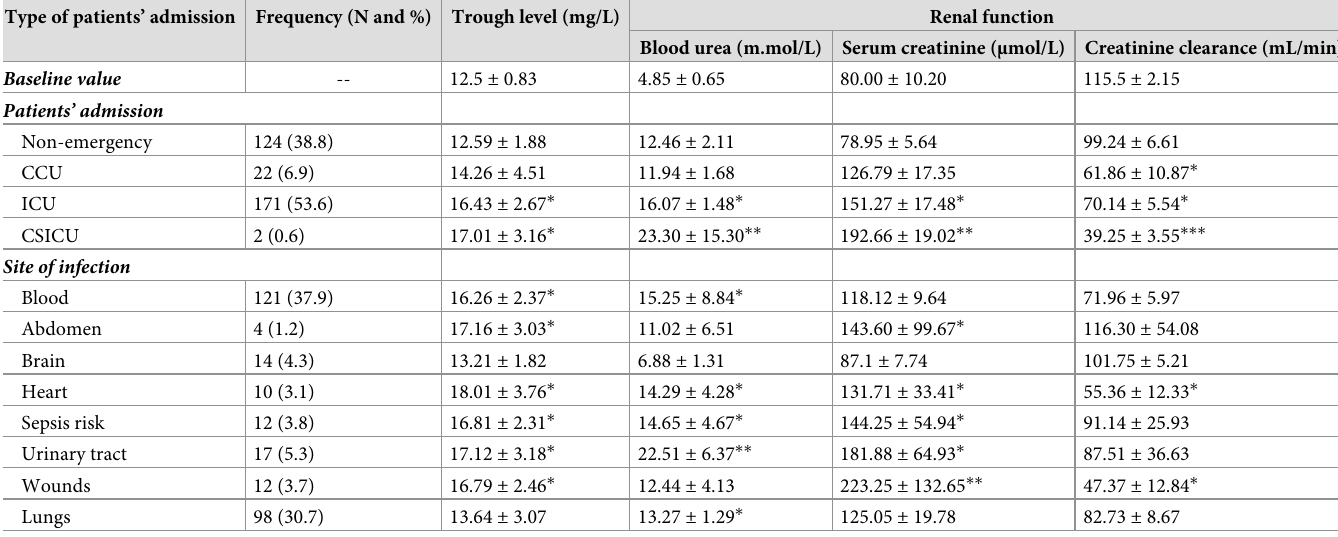
Table 4. Effect of vancomycin on renal function in different types of patients’ admission and site of infections. Type of patients’ admission Frequency (N and %) Trough level